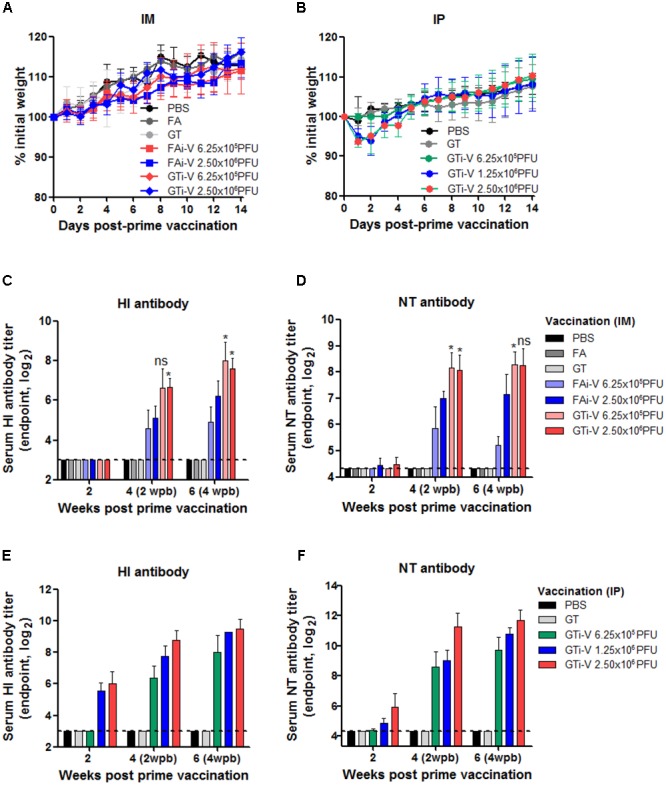
Neutralizing antibody responses elicited by GTi influenza viruses. (A,B) Vaccination of mice with FAi or GTi virus. Mice (n = 4 or 5) were vaccinated with FAi or GTi virus with an interval of 2 weeks, via IM (A) or (IP) (B) route. PBS, FA, and GT were used as vehicle controls. Weight changes in the vaccinated mice were monitored daily. (C,D) Neutralizing antibody titers elicited by IM vaccination. HI antibody titers (C) and NT antibody titers (D) in sera obtained at 2, 4 (2 weeks post-boost vaccination), and 6 (4 weeks post-boost vaccination) weeks after the prime vaccination are shown. (E,F) Neutralizing antibody titers elicited by IP vaccination. HI antibody titers (E) and NT antibody titers (F) are shown. The values are the mean of each cohort. Dashed lines indicate the detection limits of NT assay and HI assay. ∗P < 0.05 when comparing antibody titers between two different groups.